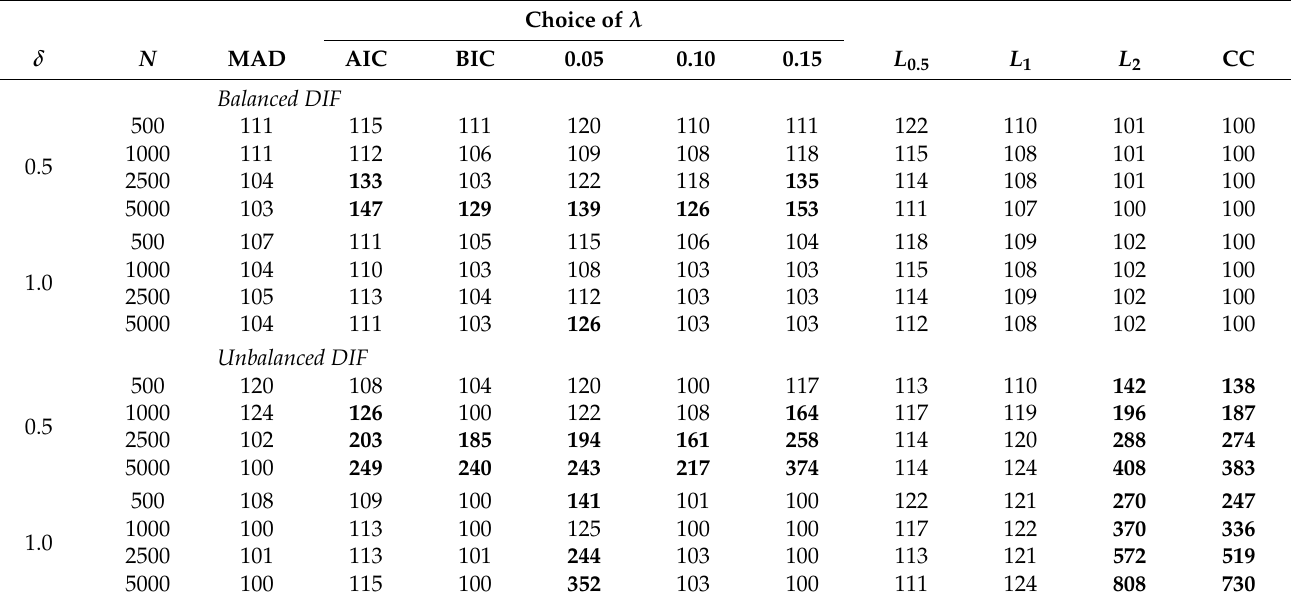
Table 2. Simulation Study 1: Relative root mean sqaure error (RMSE) of estimated group means for balanced and unbalanced DIF effects as a function of the size of DIF effects δ and sample size N . Choice of